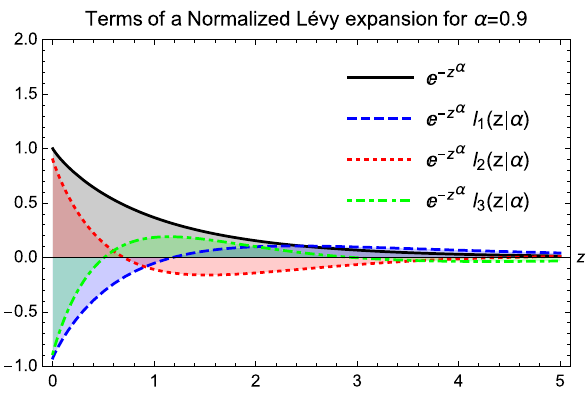
Fig. 1 Illustration of the four normalised Lévy polynomials for α = 0 . 9